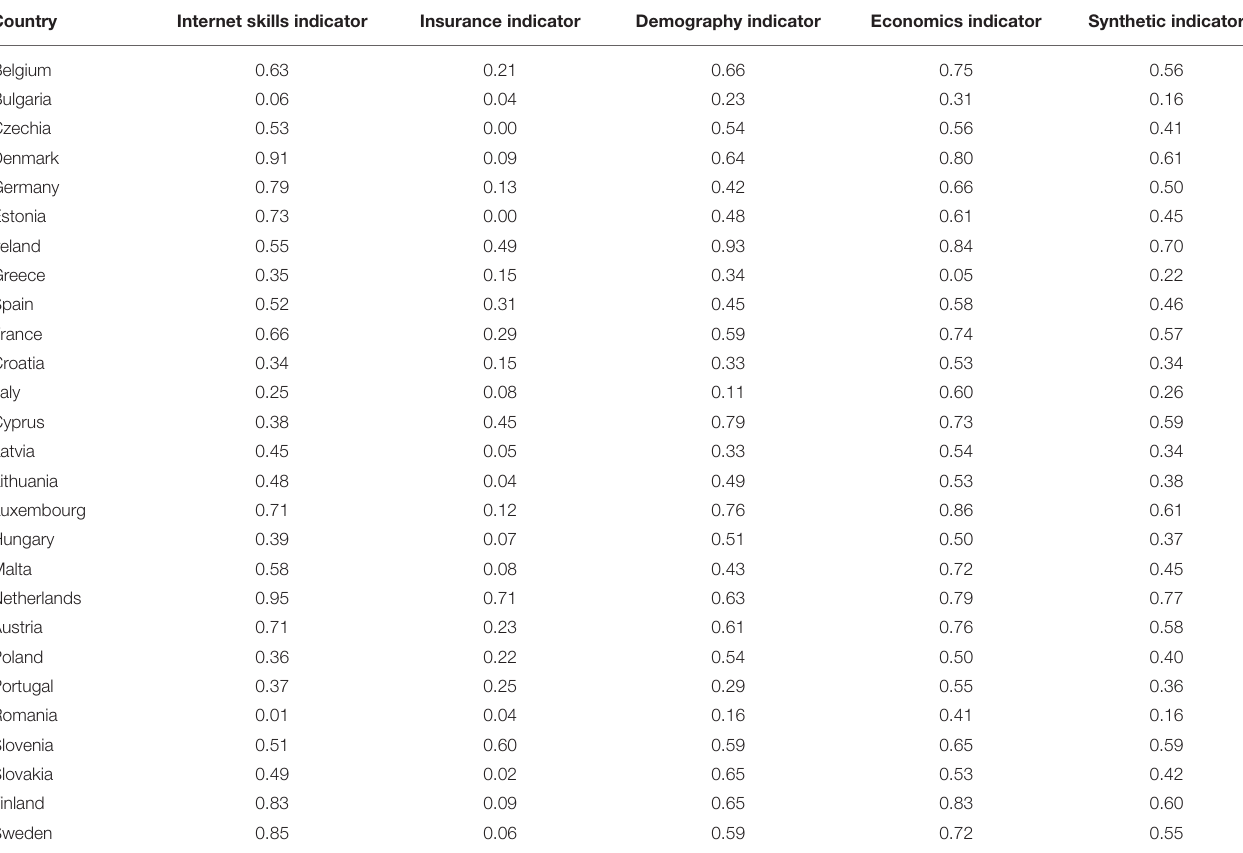
TABLE 2 | Values of sub-indicators and synthetic indicators for EU countries. Country Internet skills indicator Insurance indicator Demography indicator Economics indicator Synthetic